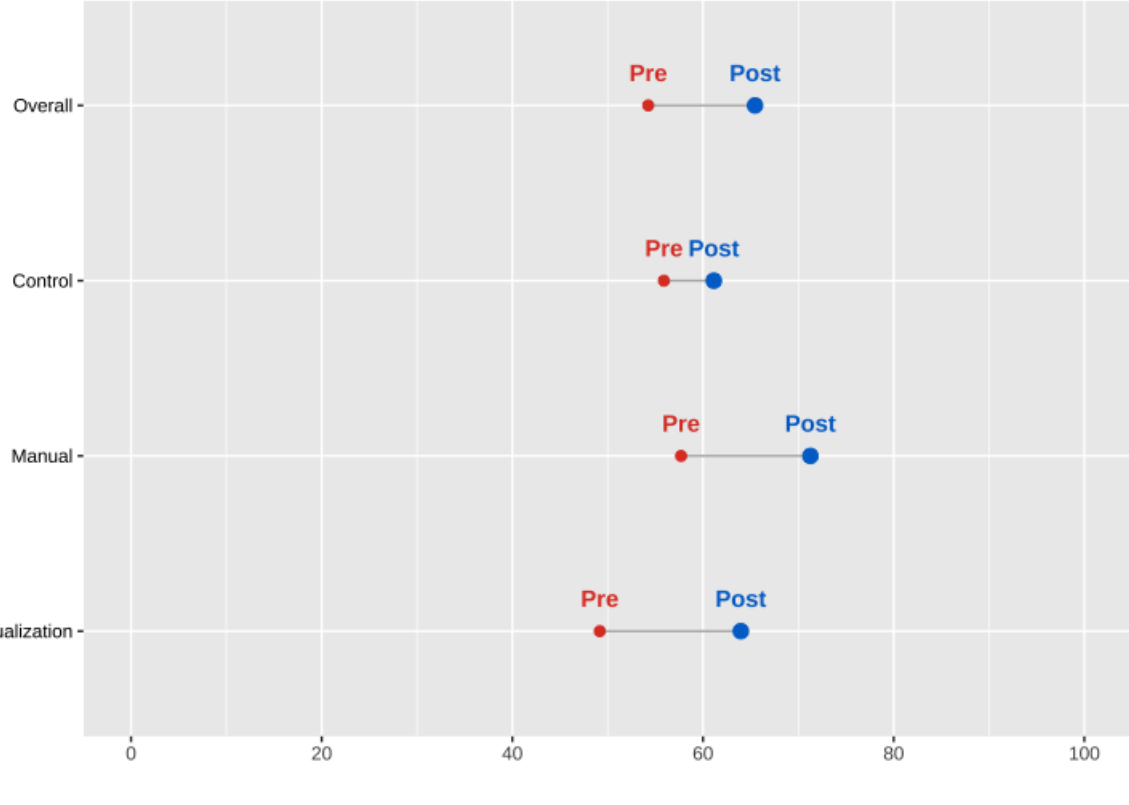
Figure 3 Driver knowledge before and after